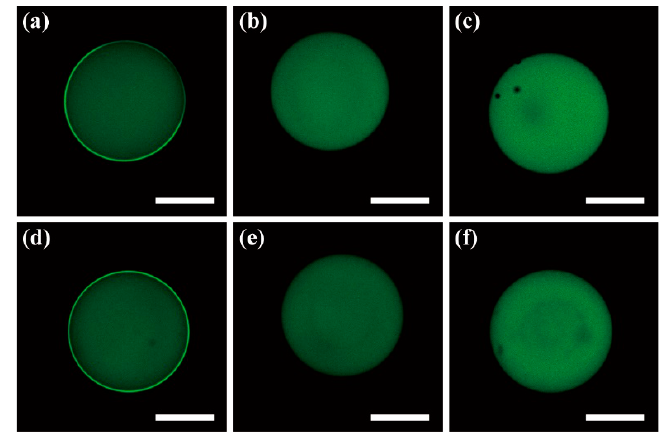
Figure 8. Florescent images showing protein adsorption at the W/O interfaces, which can be either enhanced or prevented. The oil phases in each case are: ( a ) 749 Fluid; ( b ) ABIL EM 90; ( c ) KF-6038; ( d ) Silicone oil with 3% ( w / w ) 749 Fluid; ( e ) Al’s oil with 2% ( w / w ) ABIL EM 90; ( f ) Al’s oil with 1% ( w / w ) KF-6038. The fluorescent protein is eGFP. Scale bars: 500 μm.